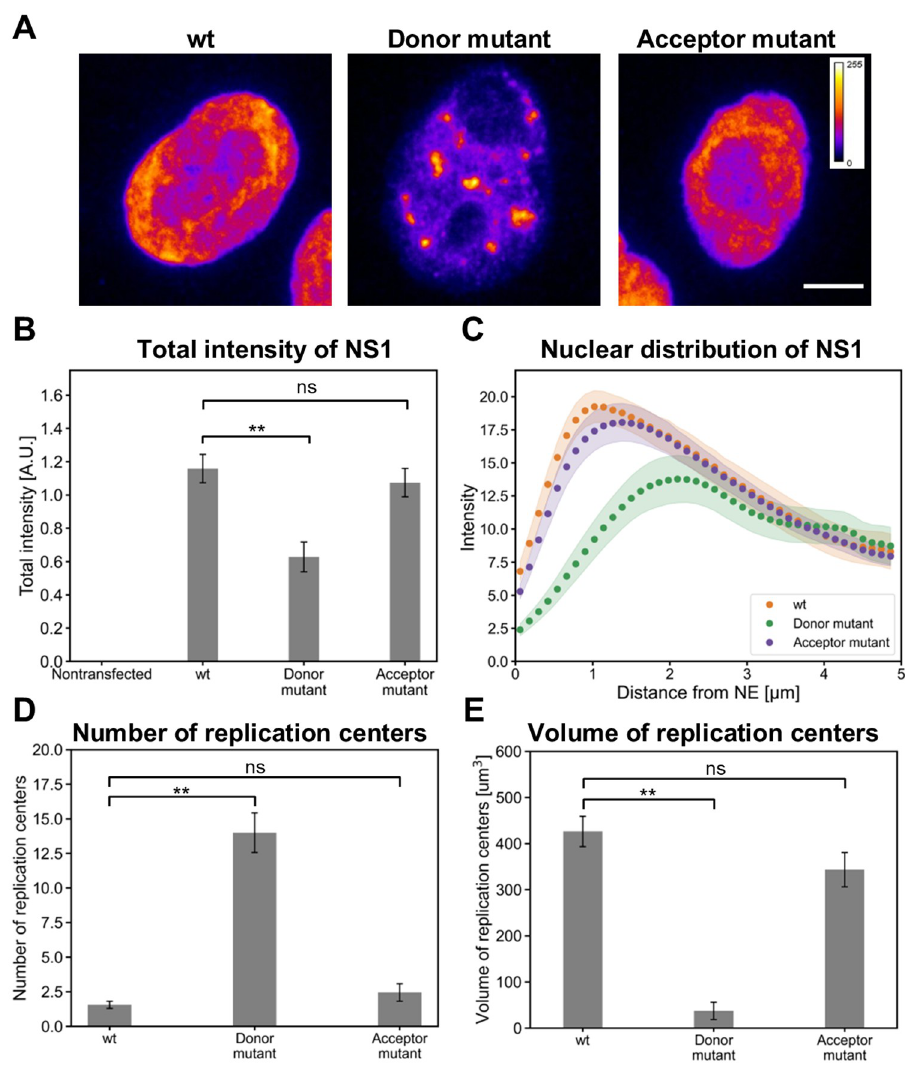
Fig 9. NS2 mutation induce changes in the number and volume of replication centers. ( A ) Representative pseudocolored sum projections of confocal image slices show the amount and distribution of nuclear NS1 in nontransfected, wt, splice donor and acceptor mutants transfected HeLa cells at 24 hpt. Calibration bar for pseudo coloring is shown. Scale bars, 5 μ m. (B ) Total fluorescence intensities of NS1. The error bars show the standard error of the mean. ( C ) Nuclear distribution of NS1 as a function of increasing distance from the NE in wt and NS2 mutants transfected cells (n = 29). ( D ) Numbers and ( E ) volumes of replication centers, identified by NS1 staining were analyzed in wt, splice donor and acceptor mutants transfected HeLa cells at 24 hpt (n = 29). The error bars show the standard error of the mean. Statistical significances were determined using Dunnett’s multiple comparison test. The significance values shown are denoted as �� (p < 0.01), � (p < 0.05) or ns (not significant).